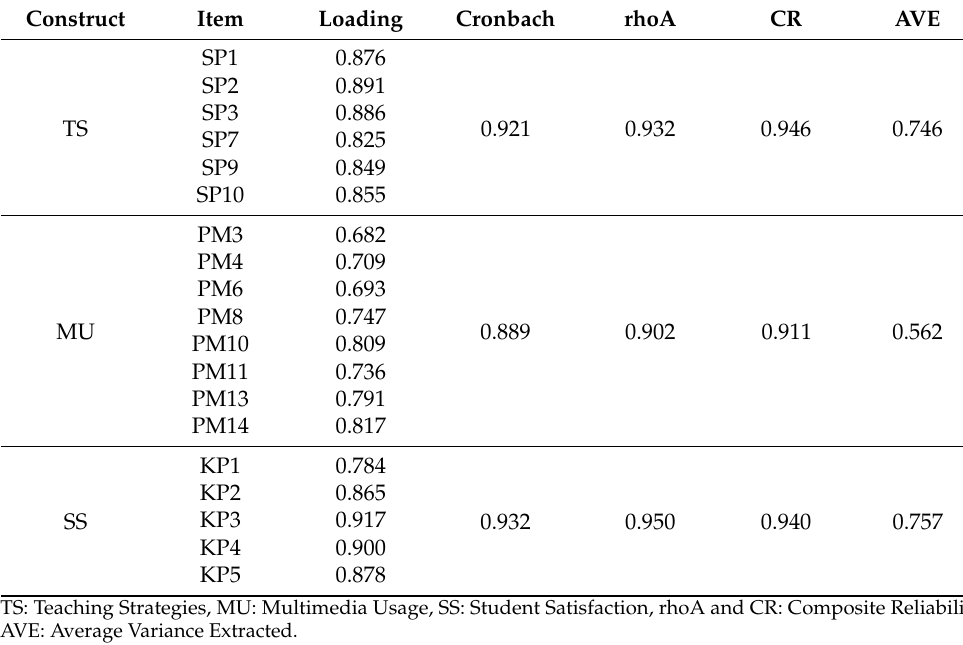
Table 1. Convergent Reliability Test.